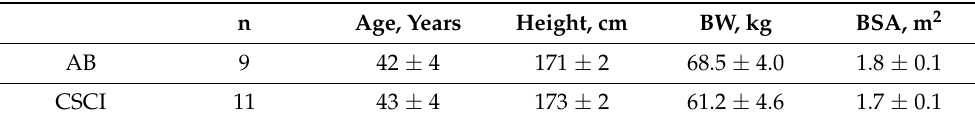
Table 1. Characteristics of